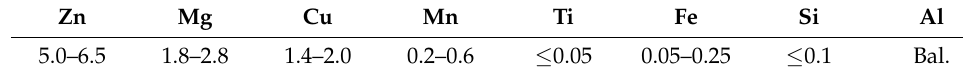
Table 1. Chemical composition of the 7B04 aluminum alloy (wt.%).